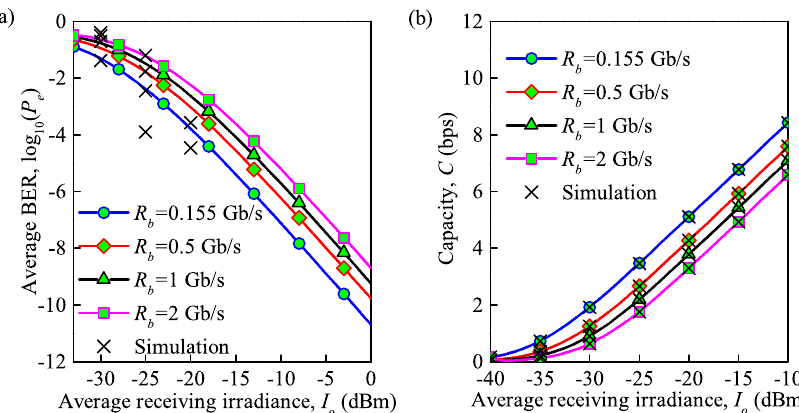
Figure 8. ( a ) Average BER for different symbol transmission rates under the influence of thermal noise; ( b ) average capacity for different symbol transmission rates under the influence of thermal noise ( C 2 n = 0.75 × 10 − 14 m − 2/3 for moderate turbulence, λ = 850 nm, T e = 300 K).